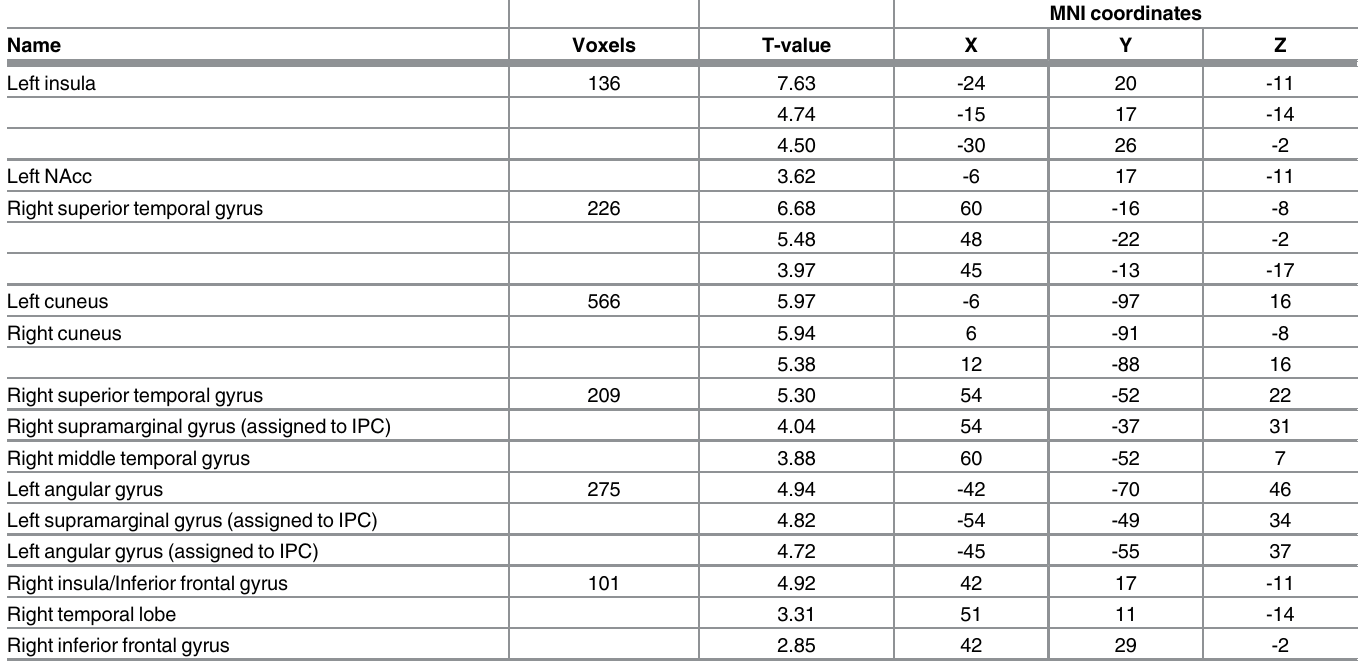
Table 3. Whole brain table for neural activation for the contrast Compensating in the exclusion block > Tossing in the exclusion block (cluster cor- rected threshold of p < .05 FDR-corrected, at an initial threshold of p <